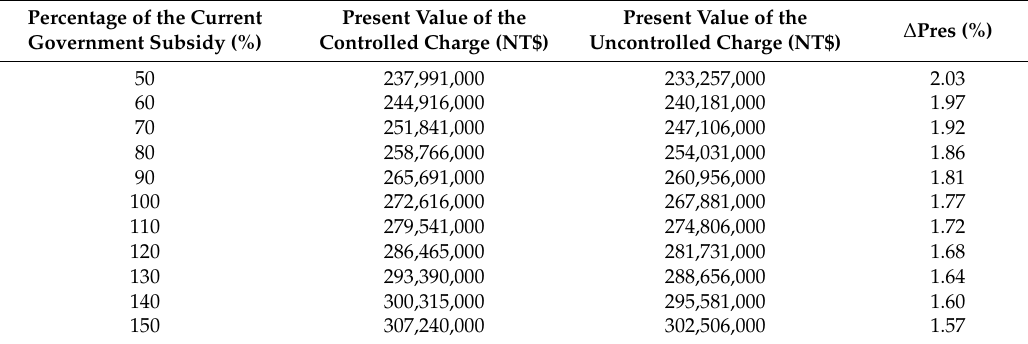
Table 9. Detailed sensitivity results of the government subsidy parameter.